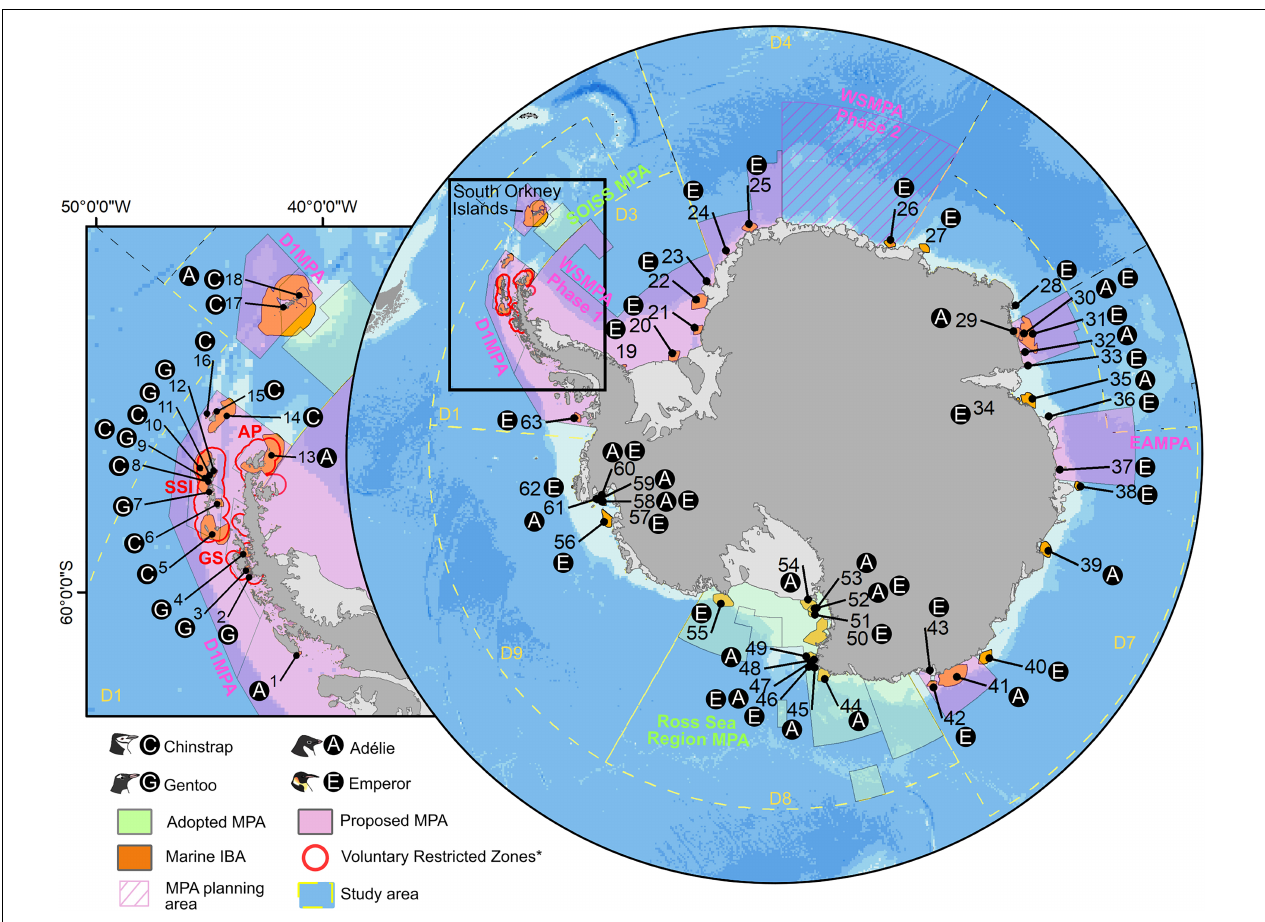
FIGURE 2 | Adopted MPAs, proposed MPAs and MPA planning area (see Supplementary Appendix – Study area and key spatial data for additional details) within the study area (CCAMLR MPA planning domains (D) 1, 3, 4, 7, 8, and 9), and overlap with identified network of 63 marine IBAs for penguin species. Text black circles adjacent to marine IBAs indicate species present within the marine IBA. Adopted MPAs within the planning domains include, the Ross Sea Region MPA and the South Orkney Islands Southern Shelf MPA (SOISS MPA). Proposed MPAs include the Domain 1 MPA (D1MPA), Weddell Sea MPA Phase 1 (WSMPA Phase 1) and the East Antarctica MPA (EAMPA). Also shown are the Weddell Sea MPA Phase 2 Planning Area (WSMPA Phase 2) and the Voluntary Restricted Zones (VRZs) in which a majority of krill fishing fleets have limited their operations in certain regions during parts of the summer (AP, antarctic peninsula: 1 Oct – 1 Feb, GS, gerlache strait: 15 Oct – 15 Feb, SSI, south shetland Islands: 1 Nov – 1 Mar). Inset map area indicated by black bounding